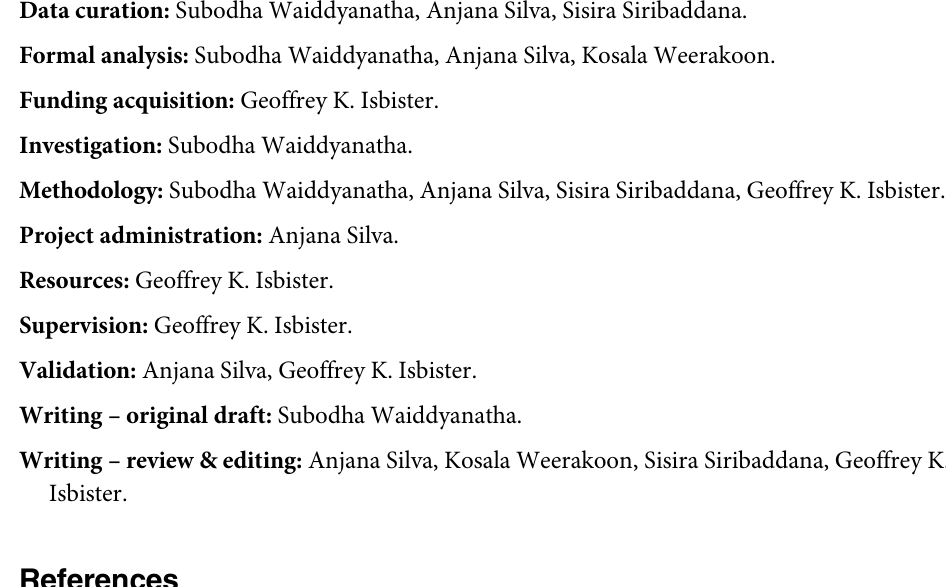
S1 Table. Descriptions of the patients with musculoskeletal sequelae following snakebite and their impact. S2 Table. Local effects persistent in reviewed patients at the